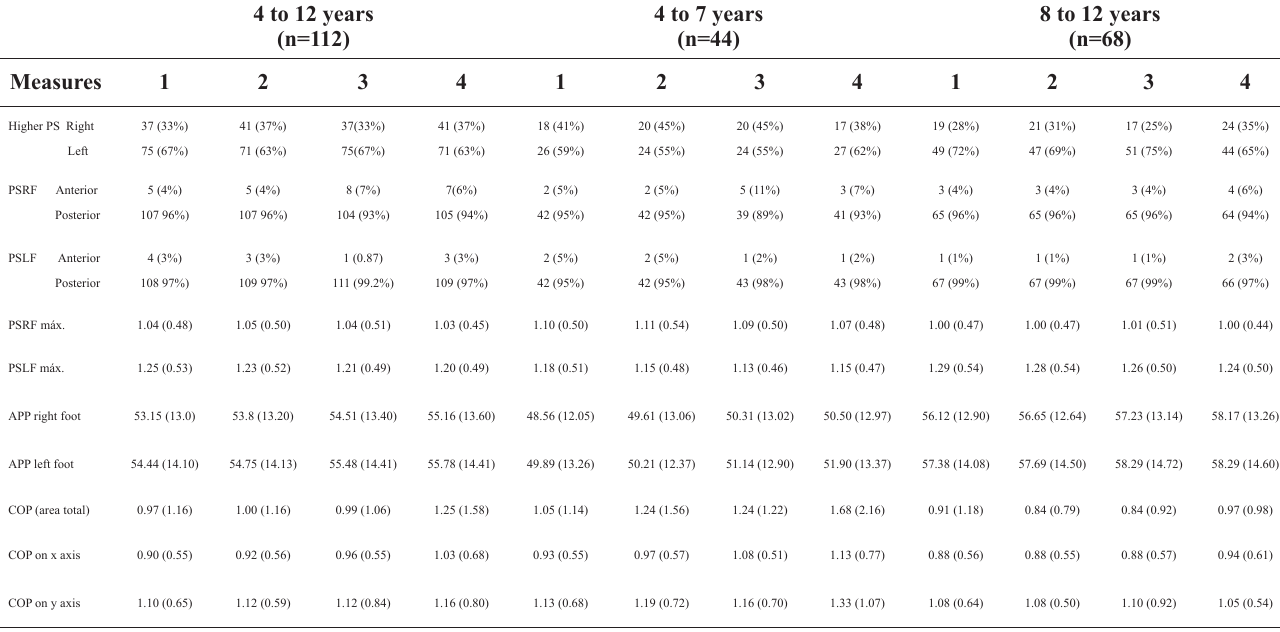
4 to 7 years (n=44)